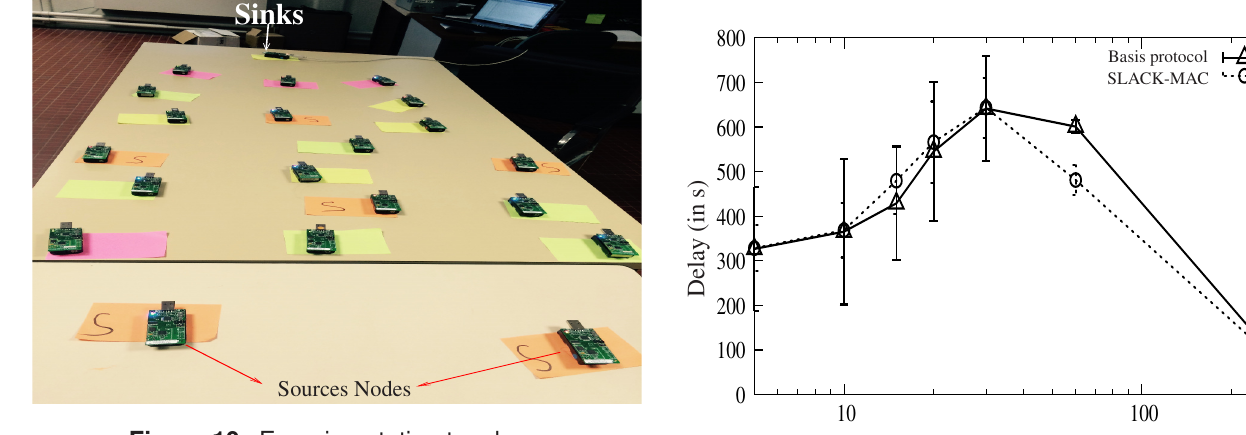
Figure 10. Experimentation topology.